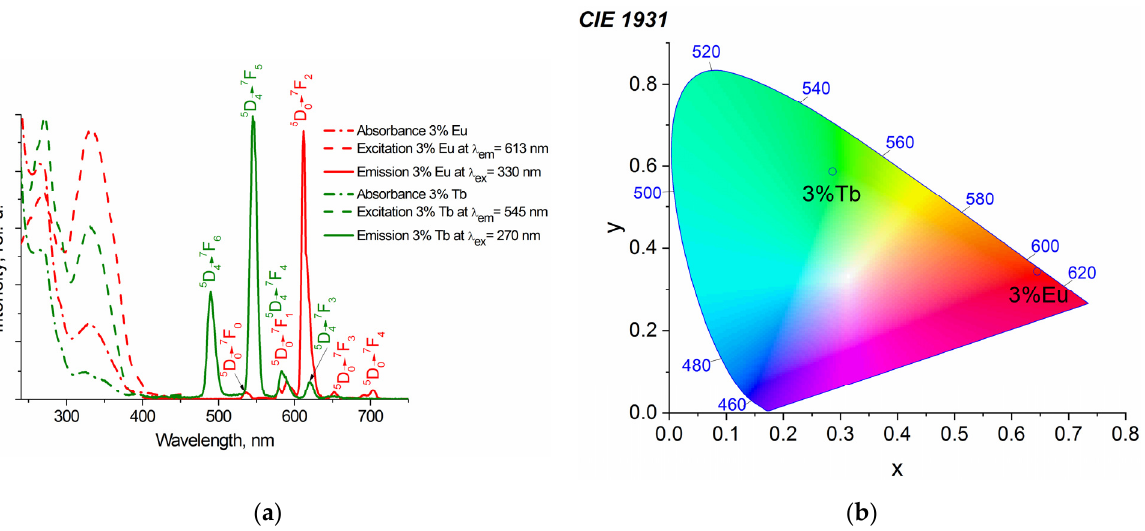
Figure 2. Luminescence and absorption spectra ( а ) and the CIE diagram ( b ) of PMMA films with 3 w.% of Tb(III) and Eu(III) complexes.